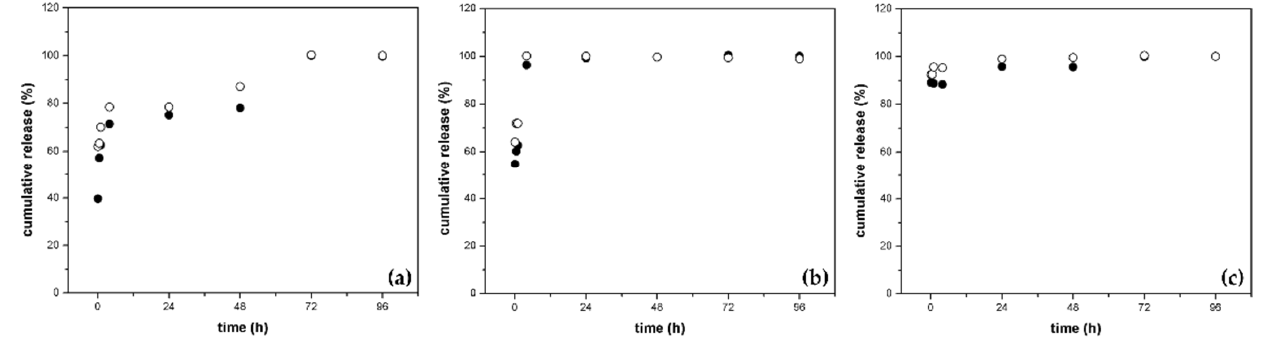
Figure 4. BTA release behavior from CMC.BTA microspheres, obtained by spray drying at: ( a ) 170 °C; ( b ) 180 °C and 440 L/h; and ( c ) 190 °C. Spray flow rates 440 L/h (closed) and 600 L/h (open).